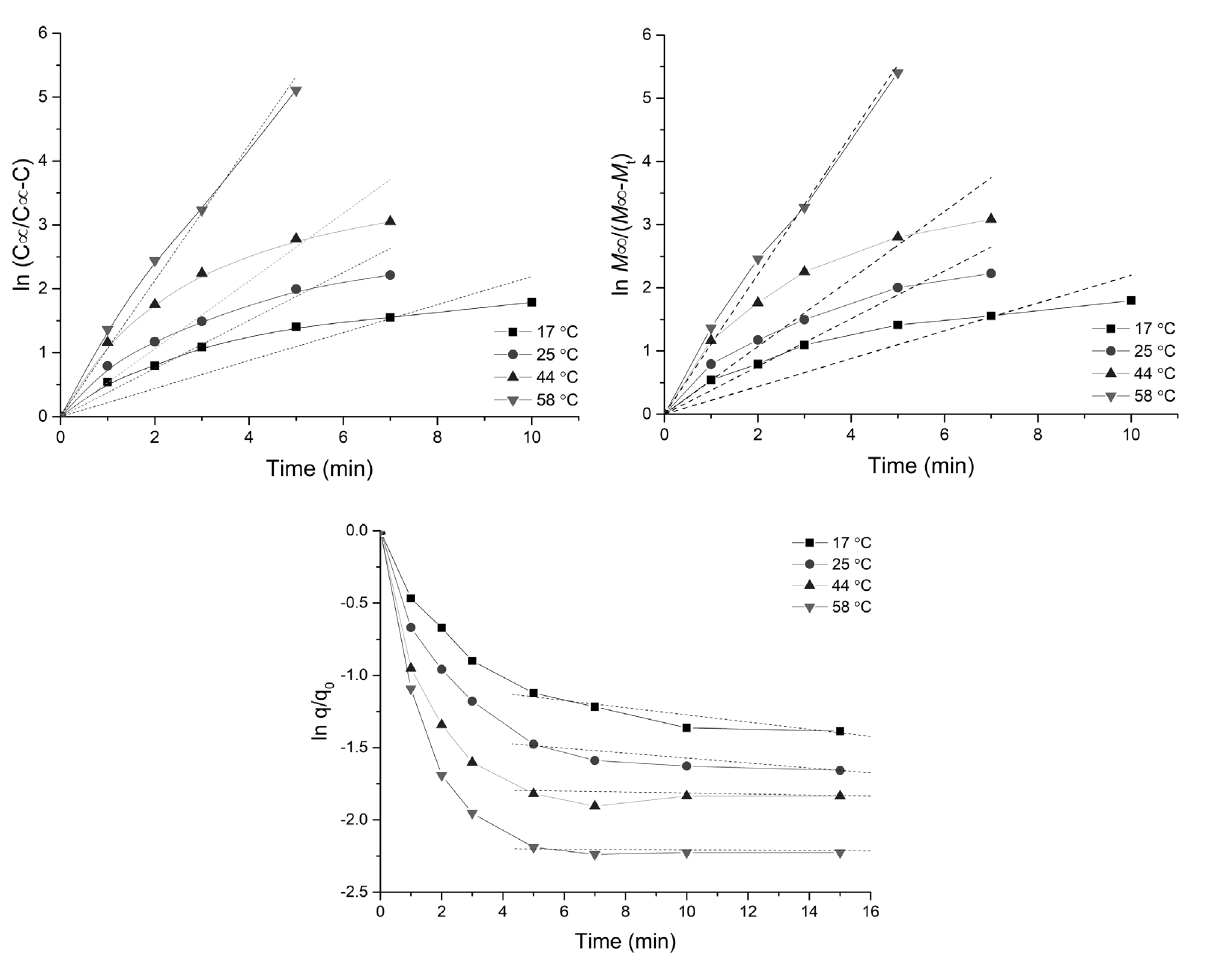
/ M - M ], (c) ln q/q vs. time of caffeine extraction under the action of UESC ∞ ∞ t 0